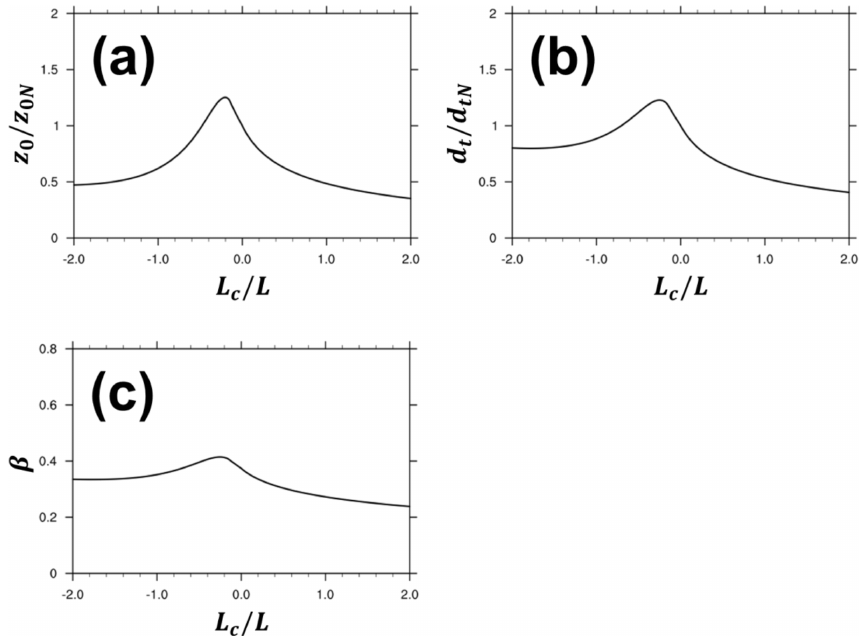
Figure 4. Roughness length (a) , redefined displacement height (b) and β (c) at a given normalized stability ( L c /L ) from the offRSL simu- lation with the YSL scheme. Roughness length and redefined displacement height are normalized by their values in a neutral condition ( z 0N and d tN ), respectively.